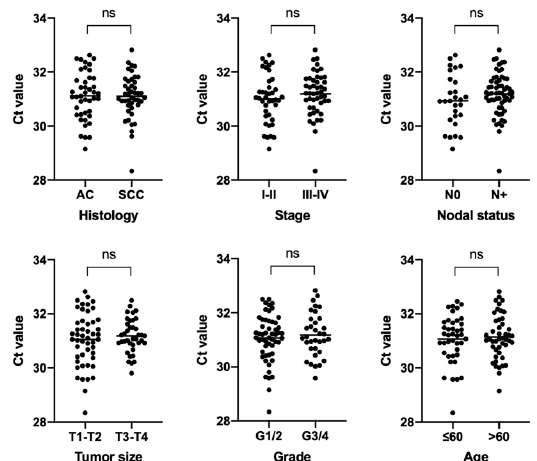
Figure 5. Real-time 16S PCR results as expressed by cycles to the cross threshold (Ct) for samples from patients with different clinicopathological characteristics. p -value evaluated with a U Mann–Whitney test.